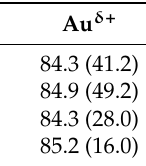
Table 3. Atomic surface composition of the samples.